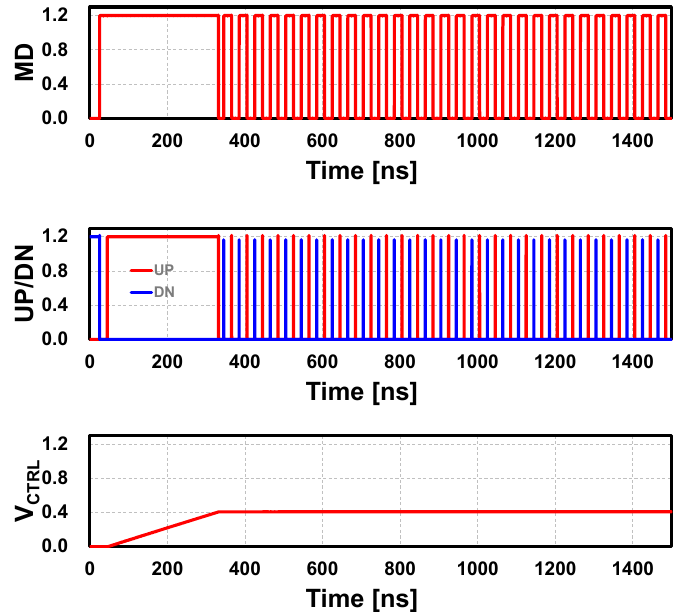
Figure 10. The locking behavior of the PD-MDV according to a 0 V V CTRL initial condition at REF = 50 MHz.